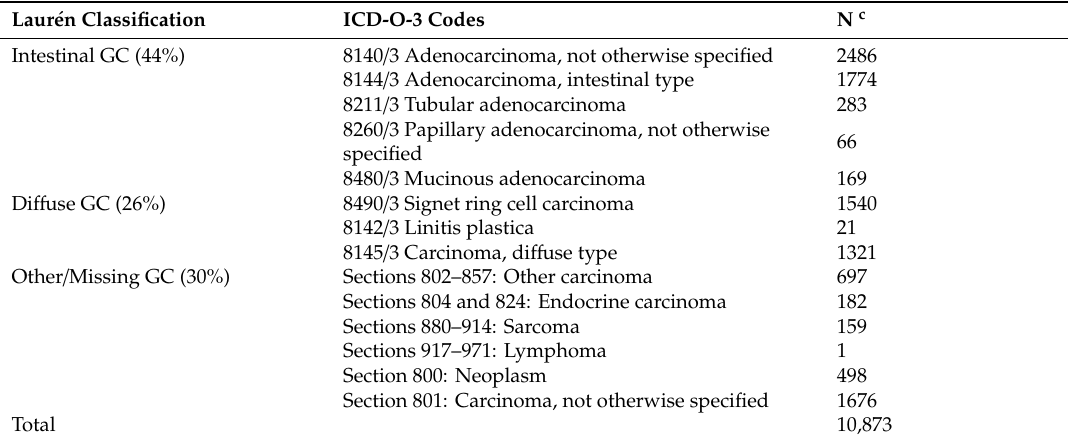
Table 1. Numbers of gastric cancer (GC) cases in the Münster population with corresponding ICD-O-3 a,b codes and classification by Laur é